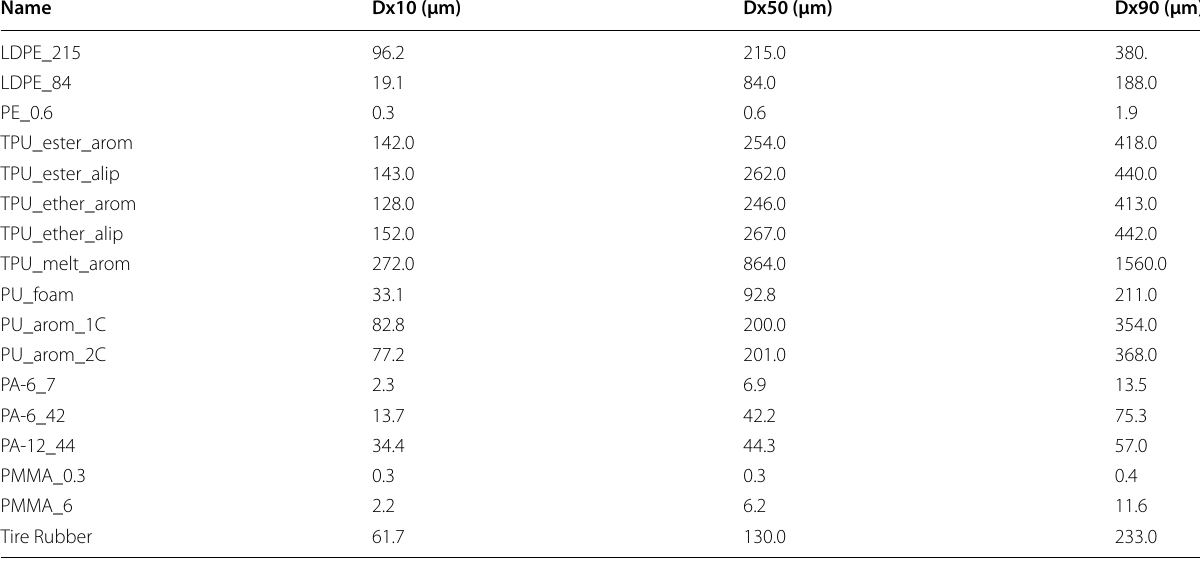
Table 1 MNPs investigated in this study and corresponding average size distributions. Detailed physical-chemical properties of all MNPs are summarized in Table